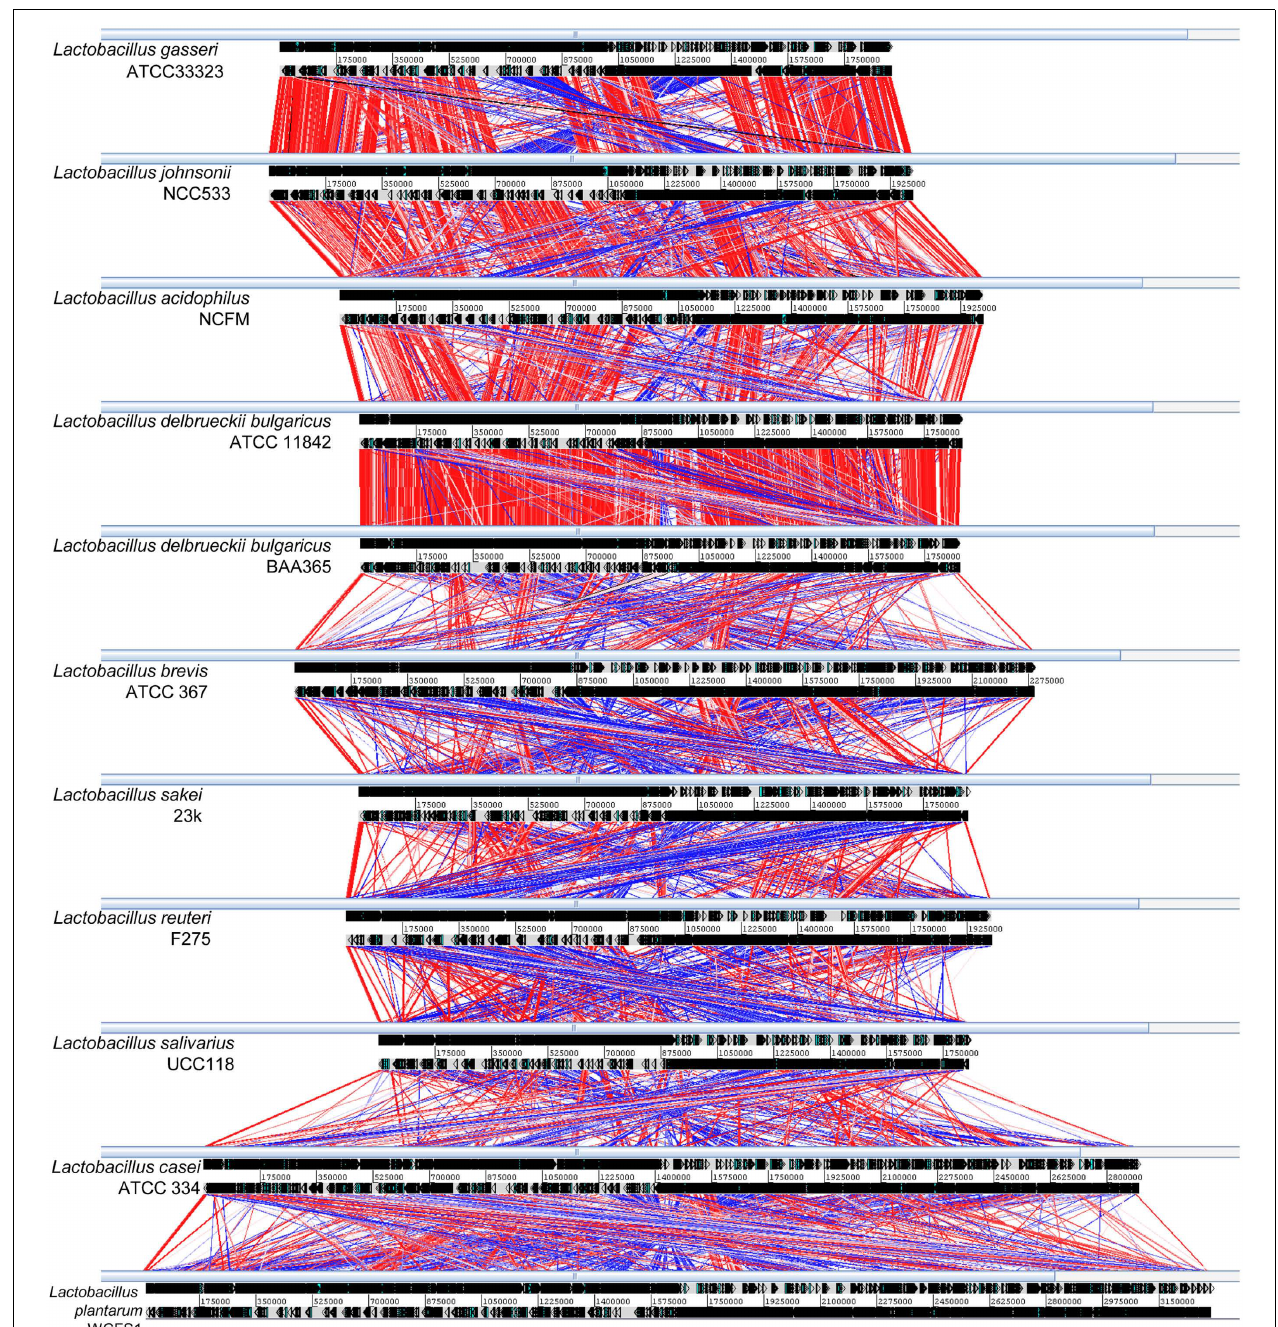
Predicted ORFs are shown on each strand in their respective orientation as arrowed boxes. Direct amino-acid similarity between individual ORFs of neighboring genomes are shown as red lines, inverted similarities are indicated by blue lines. Color shadings indicate the level of similarity, the more saturated a similarity line the more conserved are two ORF-pairs. A trust level value of 40 was employed as display threshold to visualize similarity hits below an e -value of 1 e